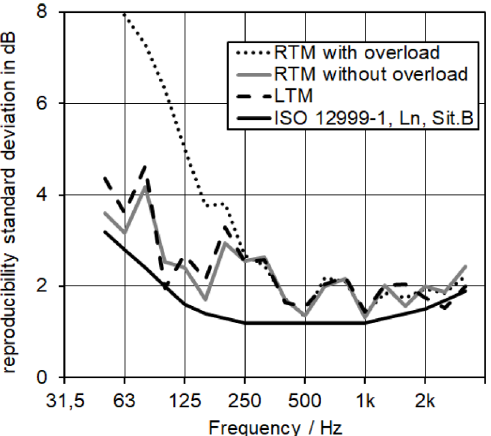
Figure 13. Standard deviation of reproducibility for the single equivalent blocked force for the round robin tapping machine RTM and the laboratory tapping machine LTM.